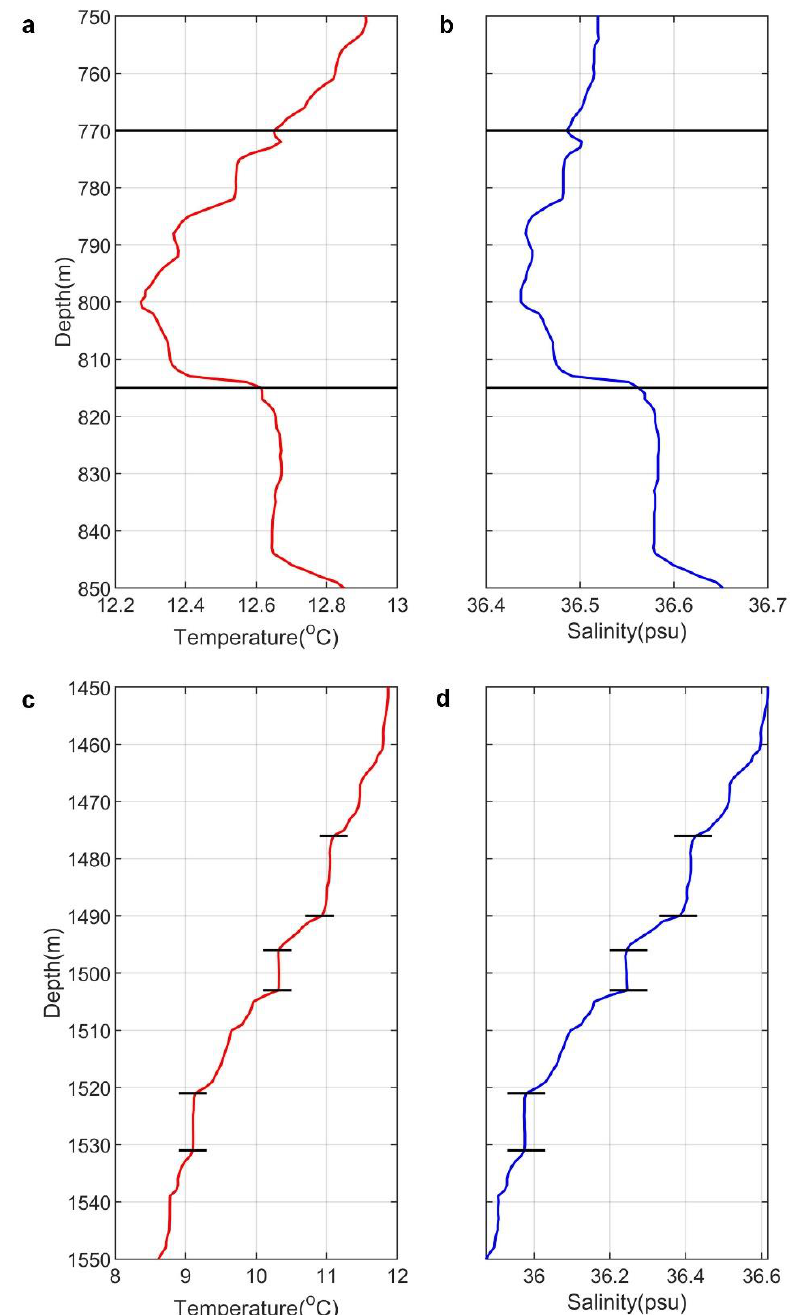
Figure 8. Staircase phenomenon caused by double-diffusive convection observed from profiles of CTD 37. ( a ) Temperature and ( b ) salinity profiles at the top edge of the meddy between 750 m and 850 m. Solid back lines mark the signs of staircases caused by diffusive convection. ( c ) Temperature and ( d ) salinity profiles at the bottom edge of the meddy between 1450 m and 1550 m. The solid black lines mark vertical steps of thermohaline staircases because of salt fingers. Three steps from above to below have heights of 14 m, 7 m and 10 m, respectively.